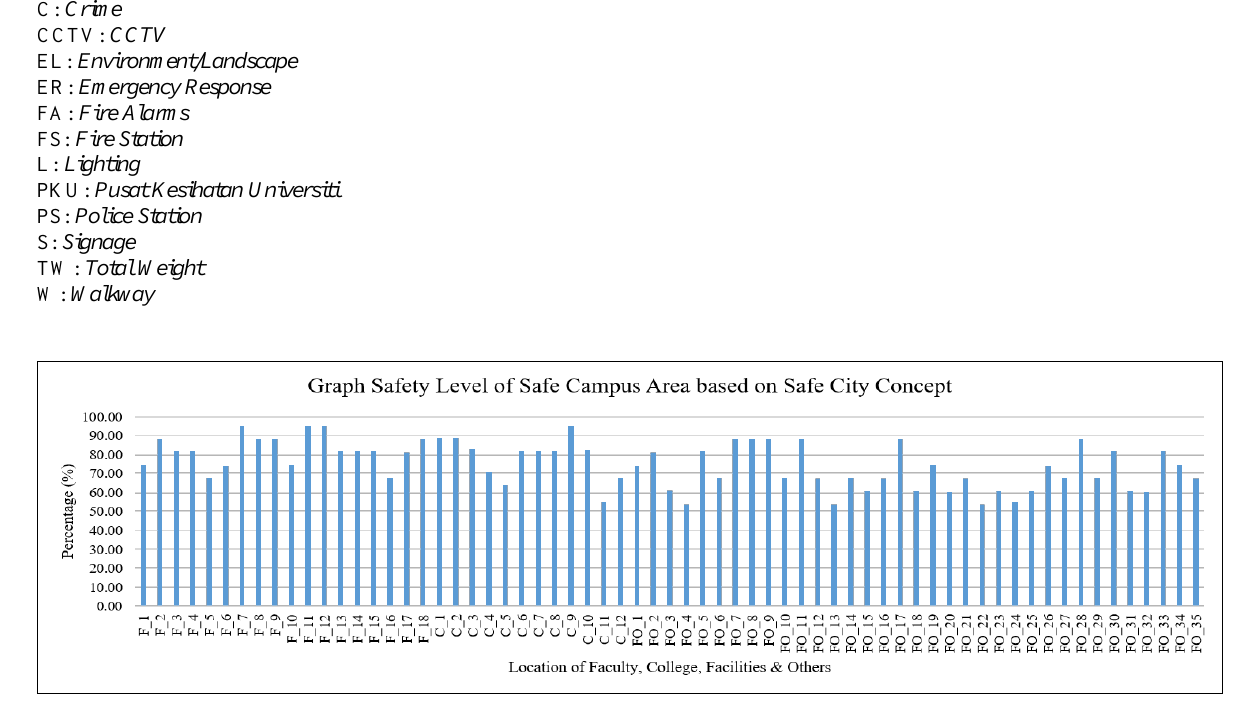
Figure 8. Graph of percentage of Safety Level for UTM